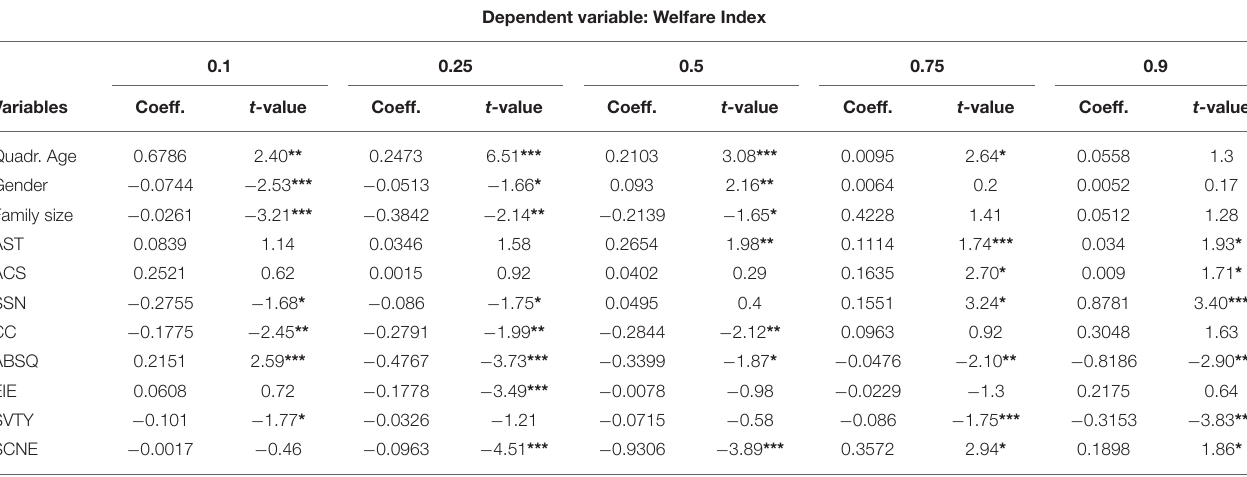
TABLE 3 | Quantile regression: effect of resilience indicators on households’ welfare